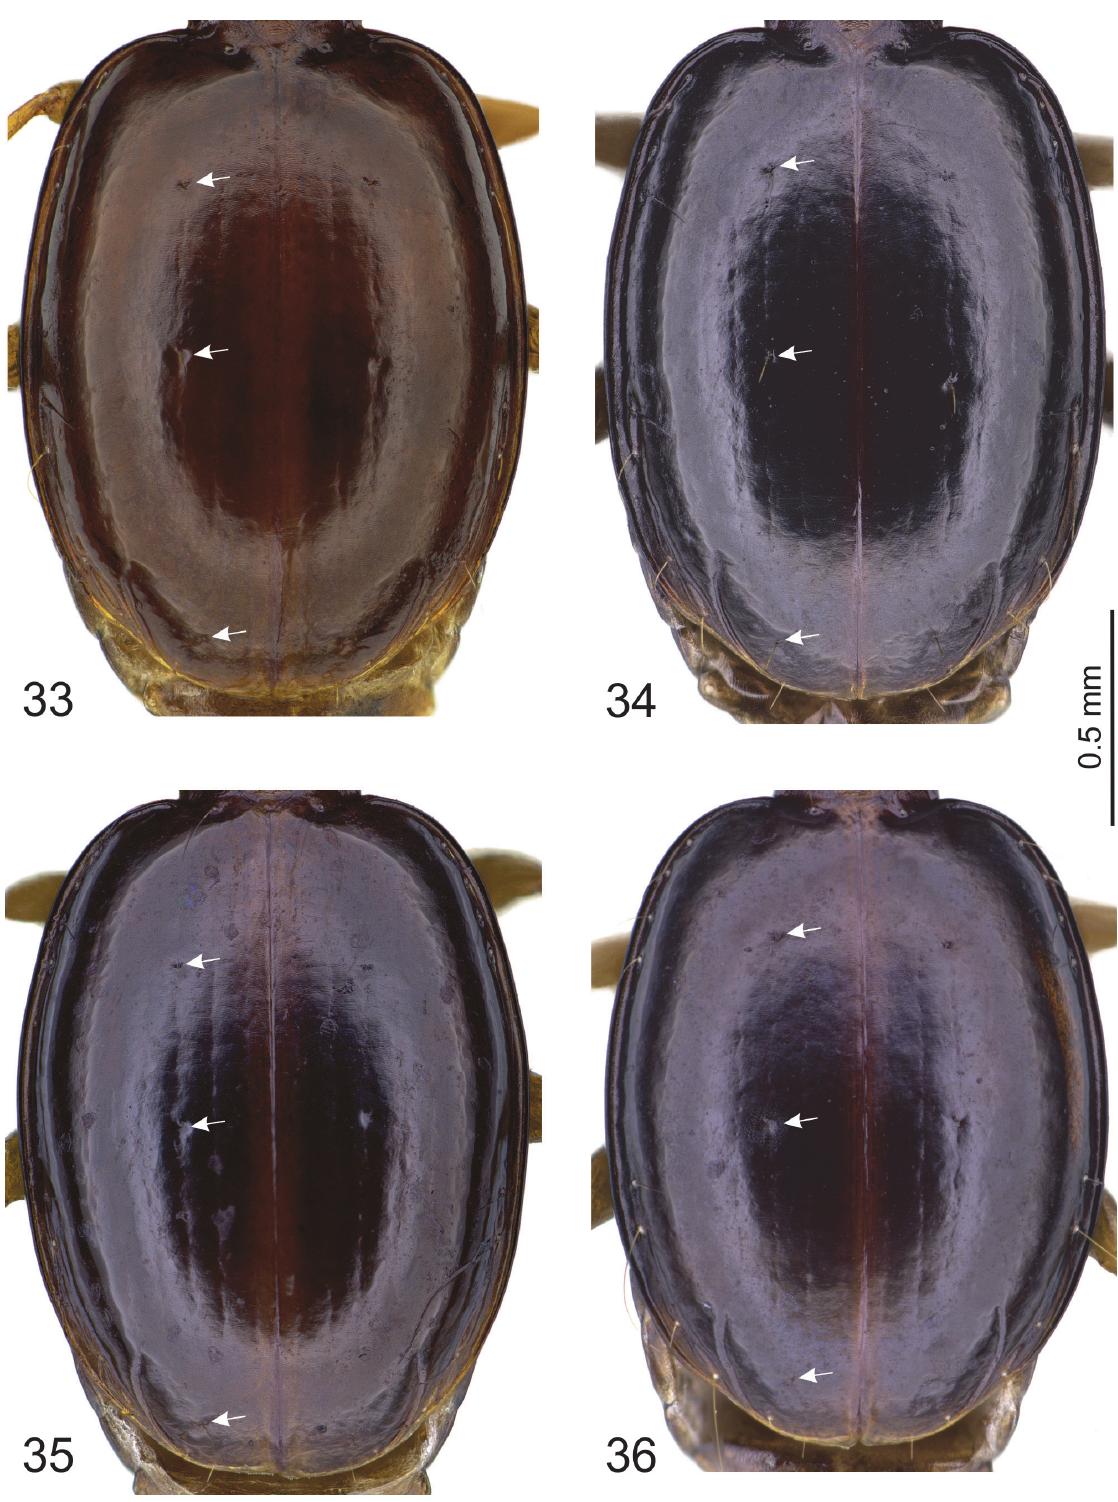
Figs 33–36. Trechus spp., elytra. 33 . T. dodola sp. nov., holotype. 34 . T. adaba sp. nov., paratype, ♂. 35 . T. harryi sp. nov., paratype, ♂. 36 . T. bayedika sp. nov., paratype, ♂. The arrows point to the insertions of the discal setae and the preapical